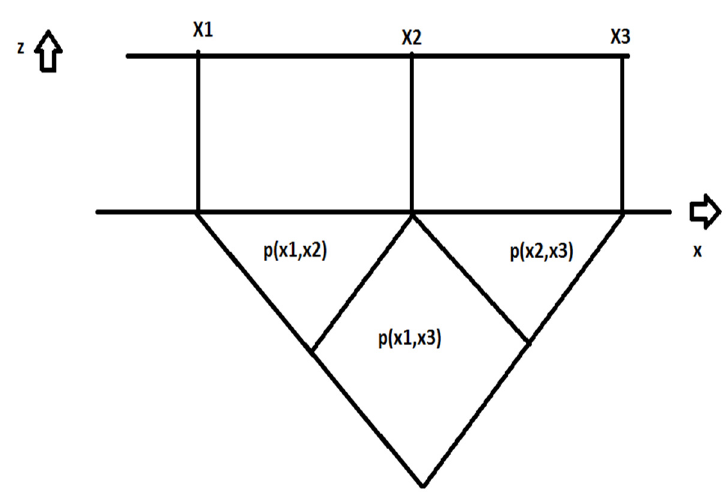
Figure 1. One and two compartment